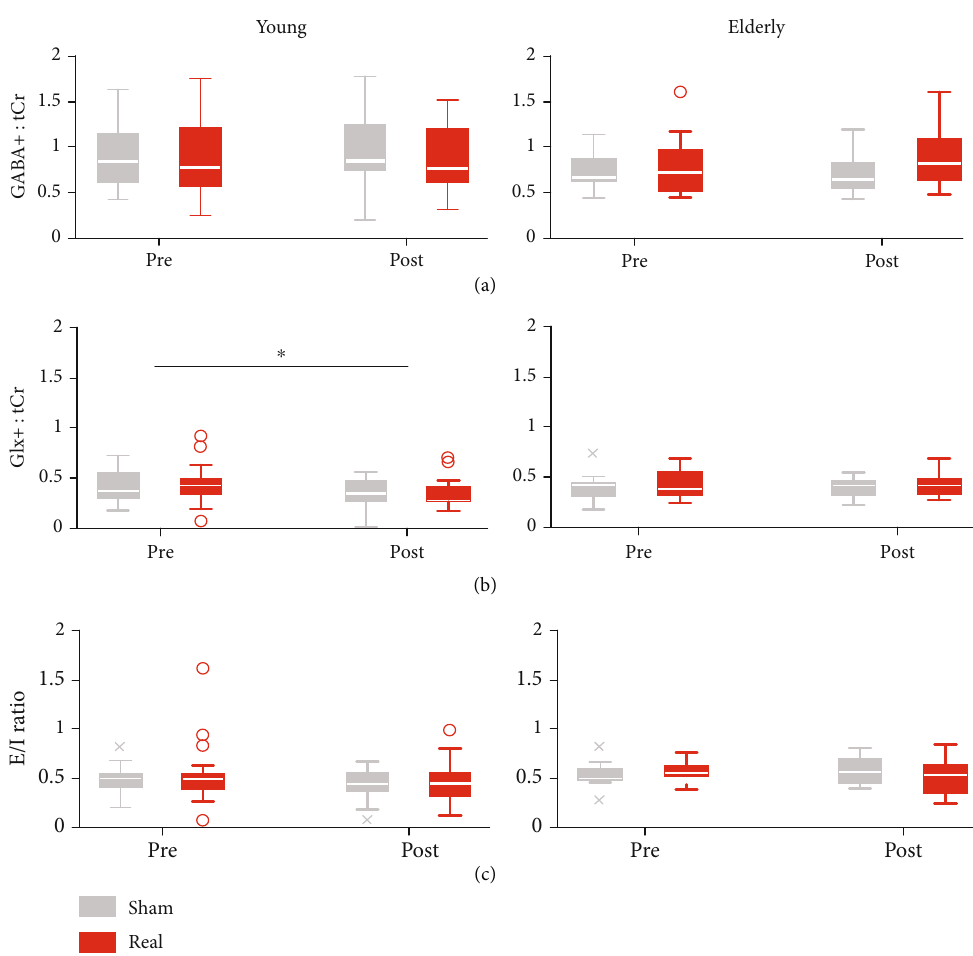
Figure 3: Neurometabolite levels pre and post anodal tDCS in young and elderly participants. (a) In both populations, no signi fi cant interactions between time and stimulation emerged for GABA+:tCr. (b) Young participants showed a reduction of Glx:tCr levels over time irrespective of stimulation condition. This e ff ect was absent in elderly. (c) E/I ratios showed no signi fi cant interaction between time and stimulation conditions in either of the two